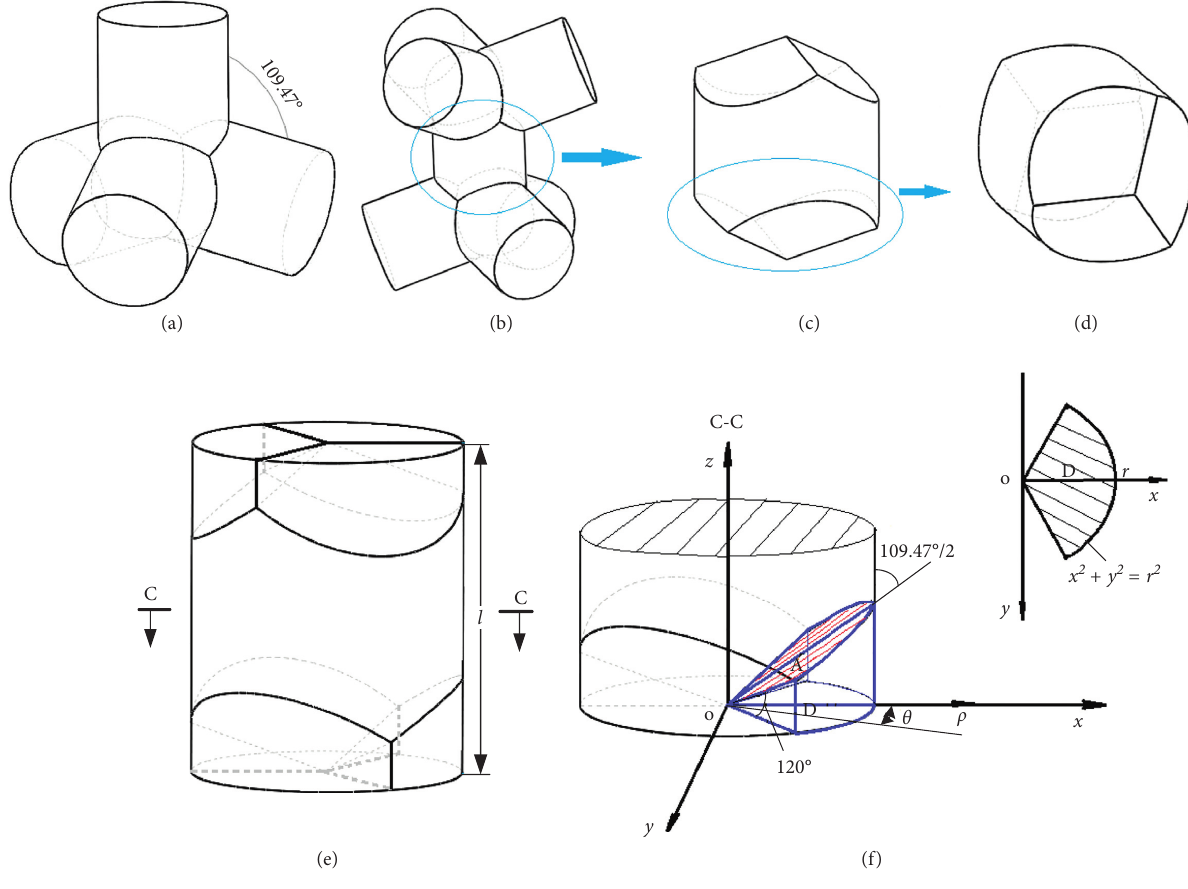
Figure 5: DLSU with ordinary nodes and their equivalent rods.